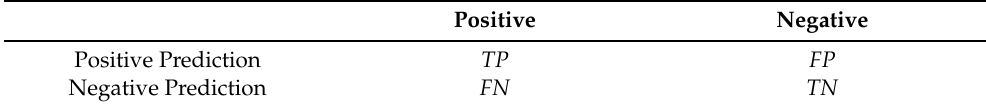
Table 1. Confusion